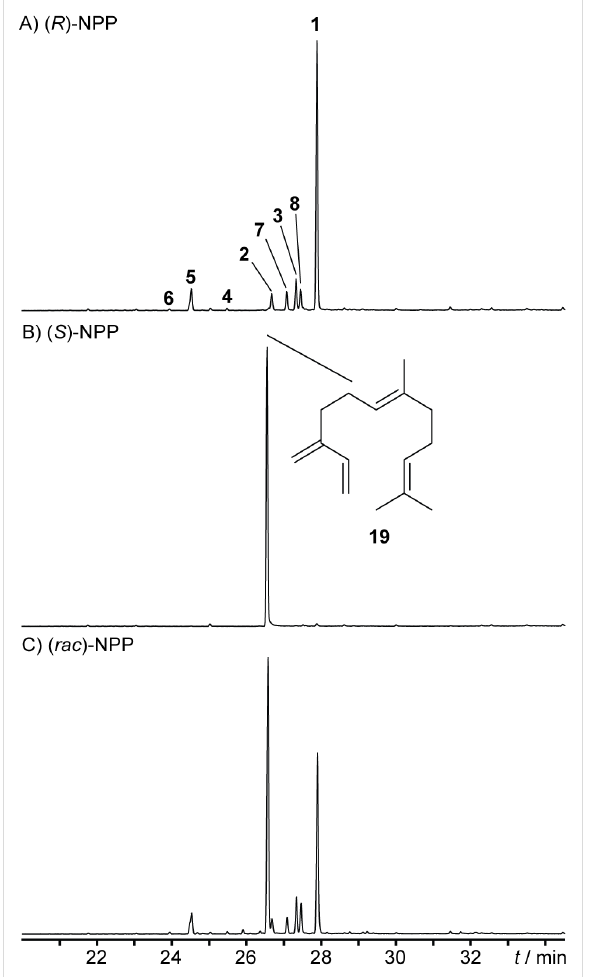
Figure 5: Total ion chromatogram of hexane extracts from HcS incu- bations with A) ( R )-NPP, B) ( S )-NPP and C) ( rac )-NPP.